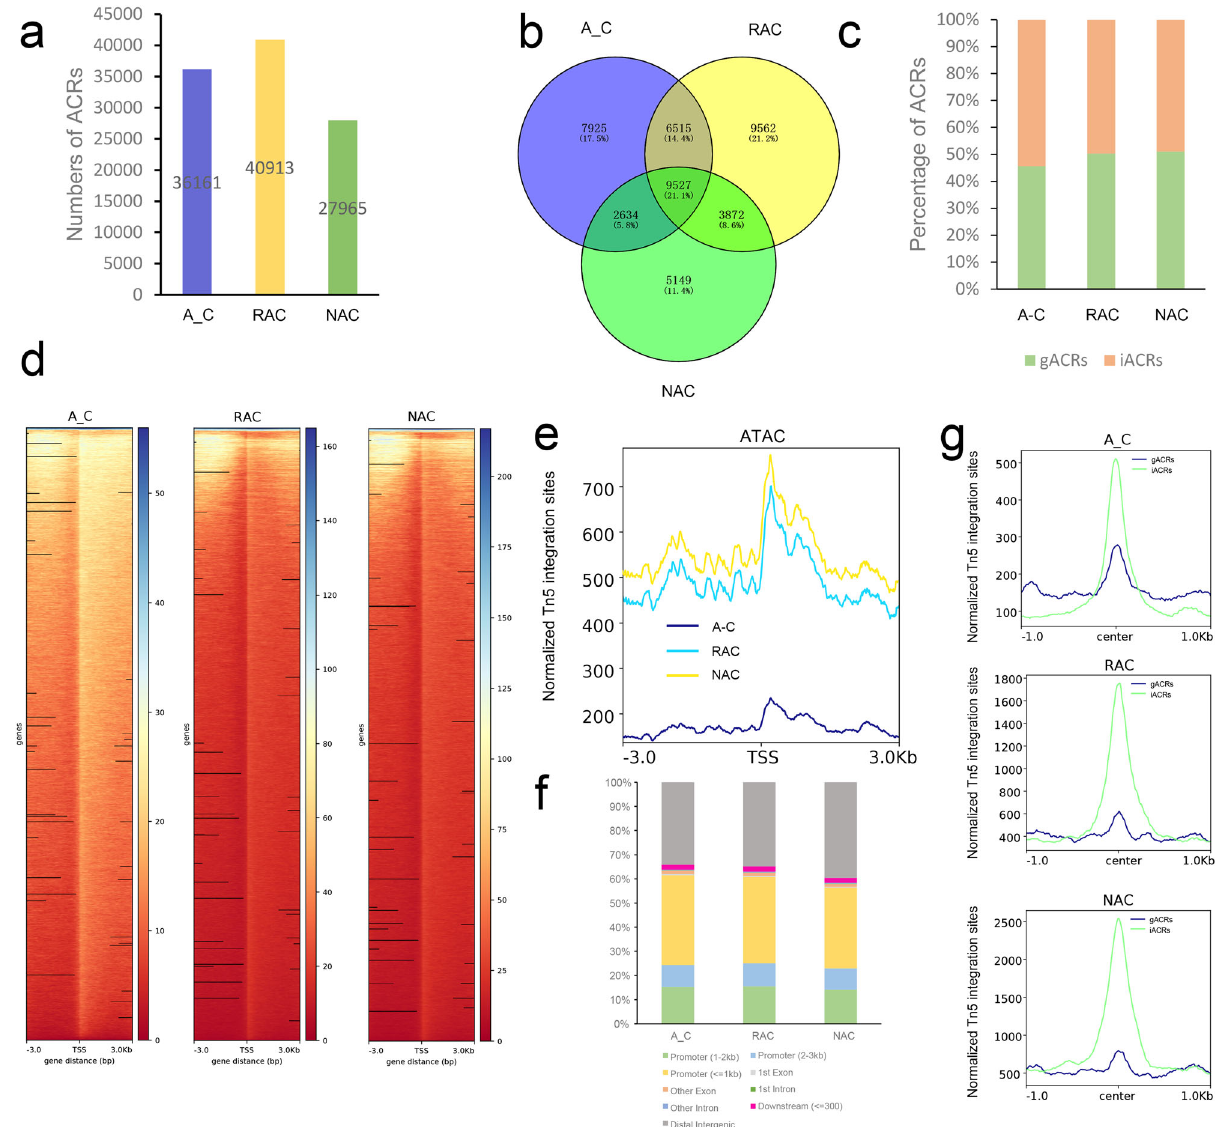
Fig. 1 Pro fi ling of chromatin accessibility in three genotypes of B. napus . a Numbers of ACRs. b Venn diagram of genes associated with ACRs. c Percentages of genic and intergenic ACRs. d Heatmaps of ACRs. e Pro fi les of ACRs. T test revealed statistical signi fi cance of the differences of chromatin accessibility among the three genotypes. f Distribution of ACRs in the genome. g Pro fi les of genic and intergenic ACRs. A_C, in silico ‘ hybrid ’ ; RAC, resynthesized B. napus ; NAC, natural B. napus ; ACRs, accessible chromatin regions; gACRs, genic ACRs; iACRs, intergenic ACRs; TSS, transcript start site; center, peak center of